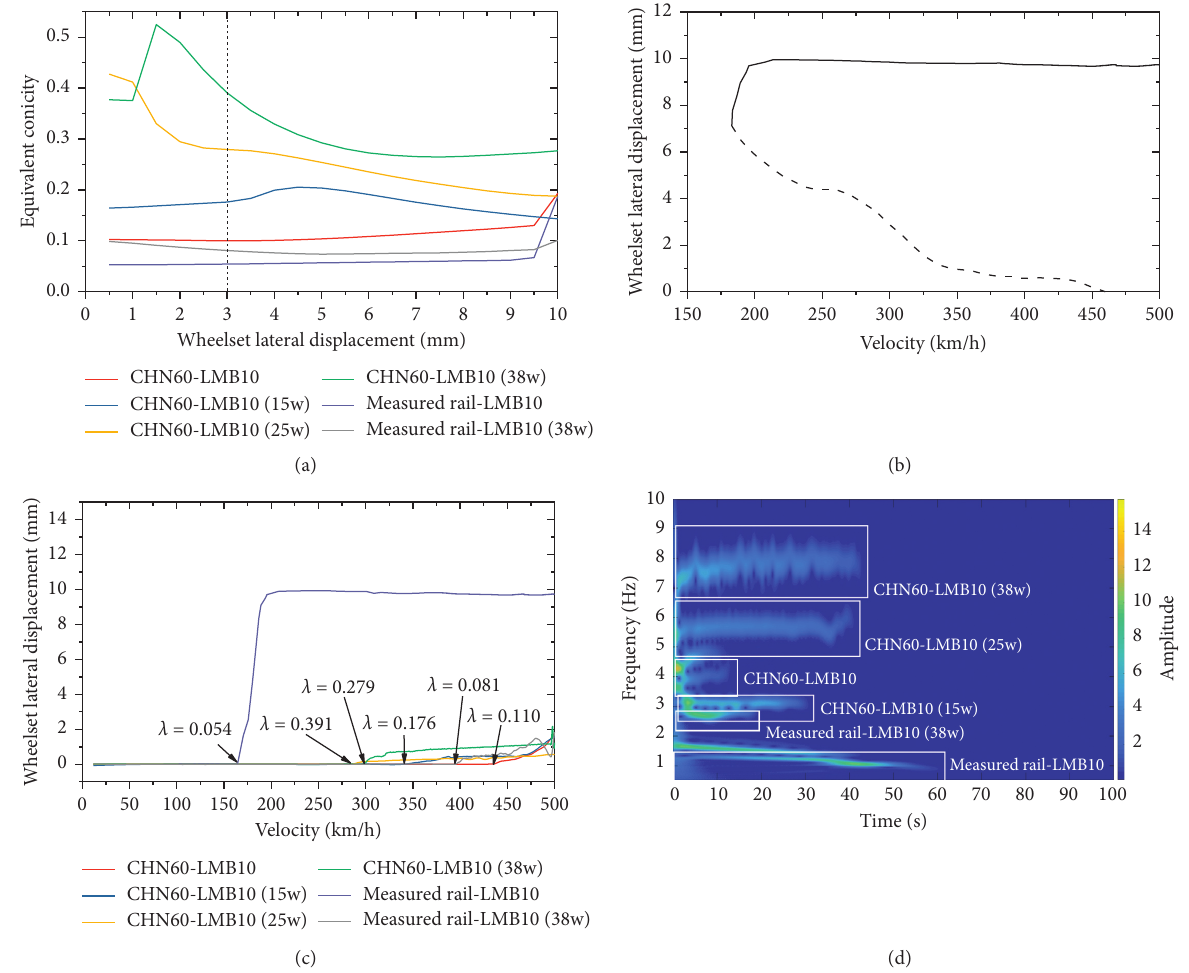
Figure 11: (a) The equivalent conicity between different rail profiles and wheel profiles. (b) The bifurcation diagram of vehicle under measured rail profile with LMB10 wheel profile. (c) Amplitude of limit cycles under different wheel-rail contact conditions. (d) Wheelset lateral displacement in time-frequency